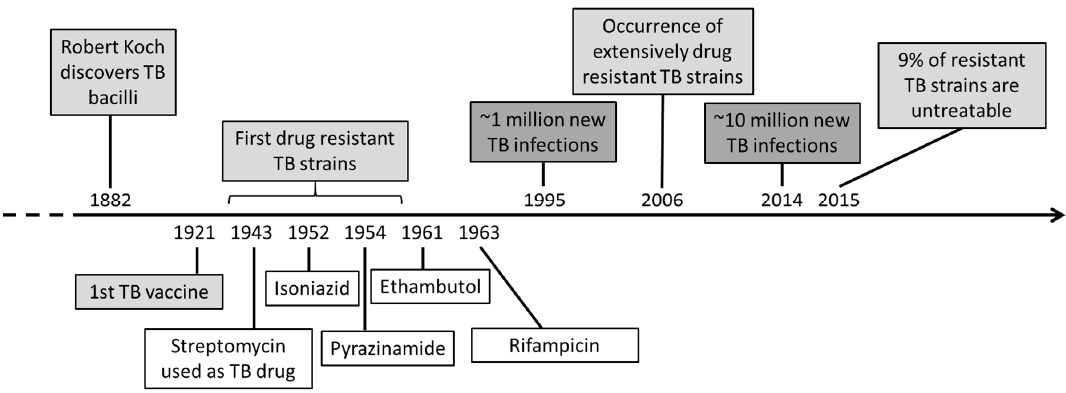
Figure 1. Timeline of tuberculosis (TB) from its discovery to treatments, current case numbers and TB research.